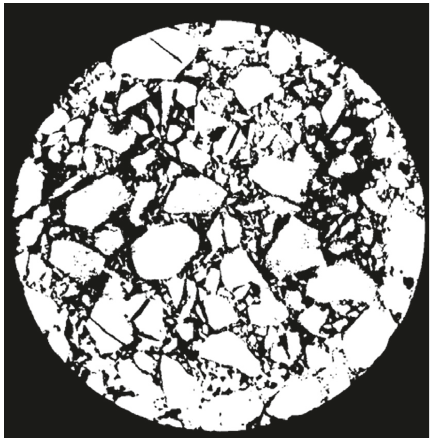
Figure 5: Aggregate image after segmentation.